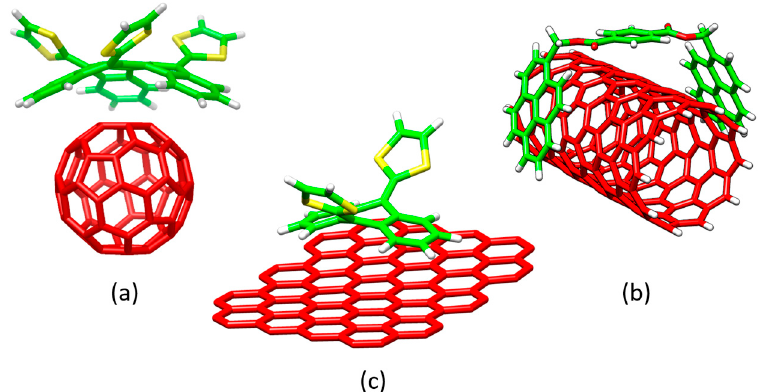
Figure 1. Selected examples of supramolecular assemblies involving fullerene ( a ), nanotubes ( b ) and graphene ( c ) with different π -conjugated electron-donors. The carbon atoms of the electron-acceptor carbon-based systems have been highlighted in red whereas the carbon atoms of the electron-donor systems are colored in green. Sulfur, oxygen and hydrogen atoms in the electron-donor systems are colored in yellow, red and white, respectively.